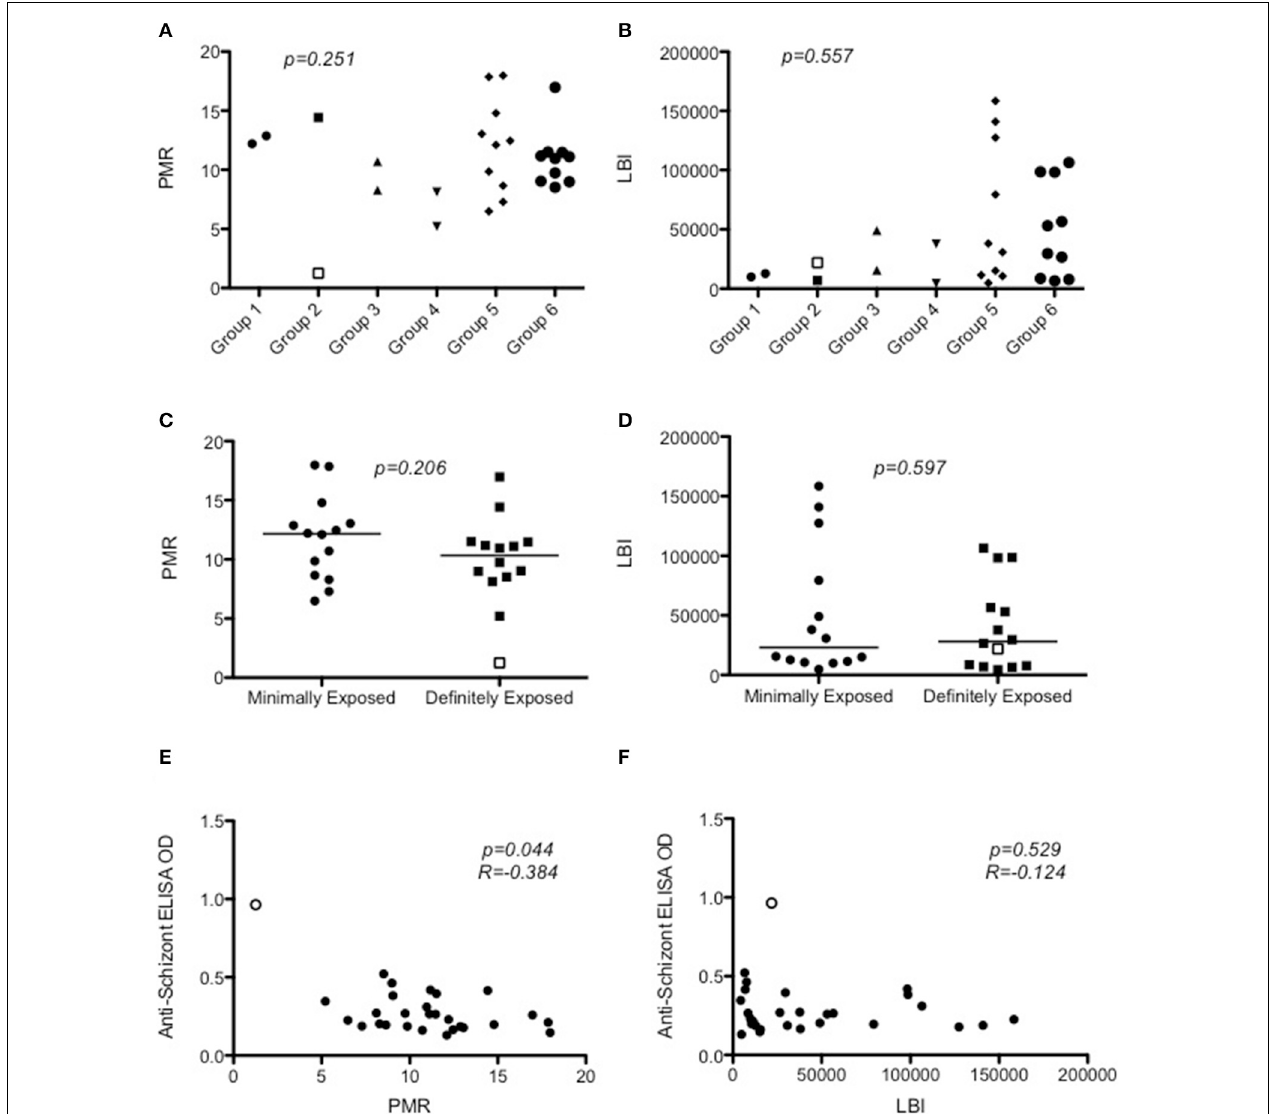
FIGURE 5 | Modeling of qPCR-measured parasite density to calculate parasite multiplication rates and liver-to-blood inocula. (A) Dot plot of PMR according to Group ( p = 0 . 251; Kruskal–Wallis test ). (B) Dot plot of LBI according to Group ( p = 0 . 547; Kruskal–Wallis test ). (C) PMR according to prior exposure to malaria ( p = 0 . 206; Mann–Whitney test ). The median value is represented by a straight line through each plot (D) LBI according to prior exposure to malaria ( p = 0 . 700; Mann–Whitney test ). Median value is